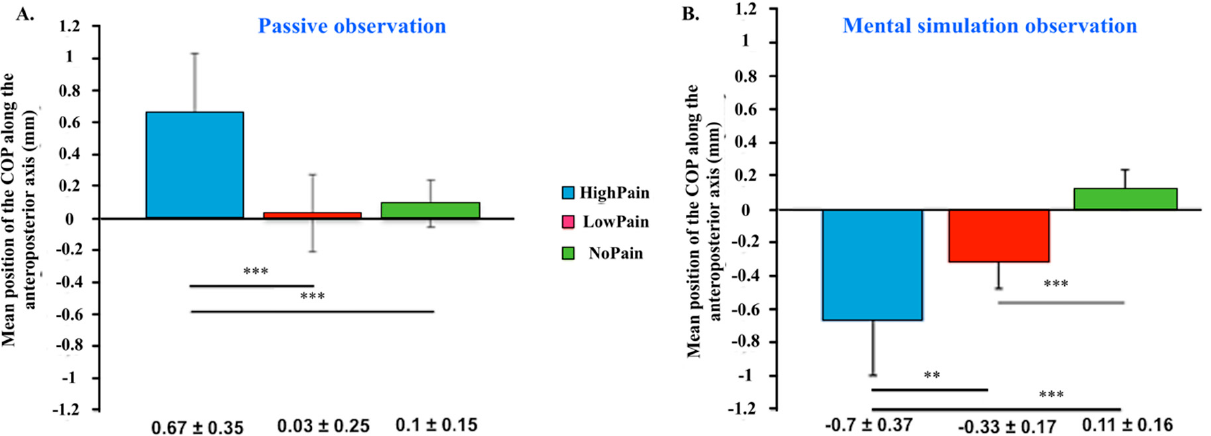
Figure 1. Mean position ( ± SEM) of the center of pressure (COP) along the anteroposterior axis of visual pain stimuli presentation in passive condition (first run, A ) and mental simulation condition (second run, B ). Significance codes: 0 ‘***’ 0.001 ‘**’ 0.01. First published in Beaumont A, Granon S, Godefroy O, Lelard T, Mouras H. Impact of pain intensity on postural response to visual exposure to painful stimuli: modulation by embodiment processes. Experimental Brain Research 2021; doi:10.1007/s00221 ‐ 021 ‐ 06102 ‐ y.